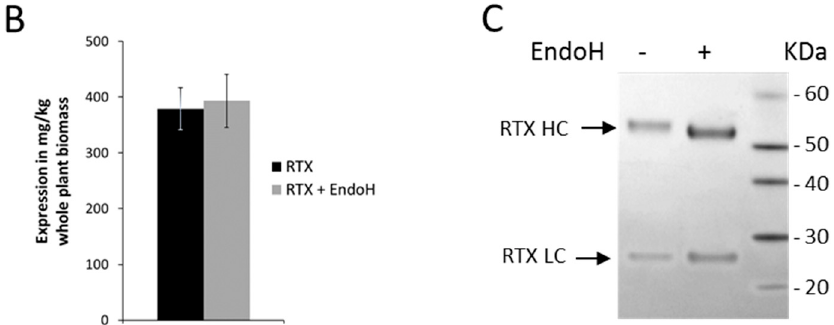
Figure 1. ( A ) Schematic representation of in vivo N -glycan processing of recombinant proteins in standard plant expression systems (Option A) and when co-expressed with EndoH (Option B). The Option B pathway illustrates the in vivo deglycosylation strategy employed for rituximab custom glycosylation where high-mannose glycans attached to the protein of interest are cleaved off by EndoH, leaving a deglycosylated substrate for in vitro transglycosylation; ( B ) plots of rituximab expression levels in mg/kg of plant biomass. Protein was harvested from plants expressing rituximab alone (black bar) or coexpressing rituximab with EndoH (grey bar) (Values are means ± SEM, n = 4); ( C ) SDS-PAGE showing rituximab under reduced conditions, with or without EndoH coexpression. The light chain (RTX LC) species for both samples migrated similarly, while the heavy chain (RTX HC) from plants coexpressing EndoH underwent an increased mobility relative to the rituximab alone, indicating a decrease in molecular weight.